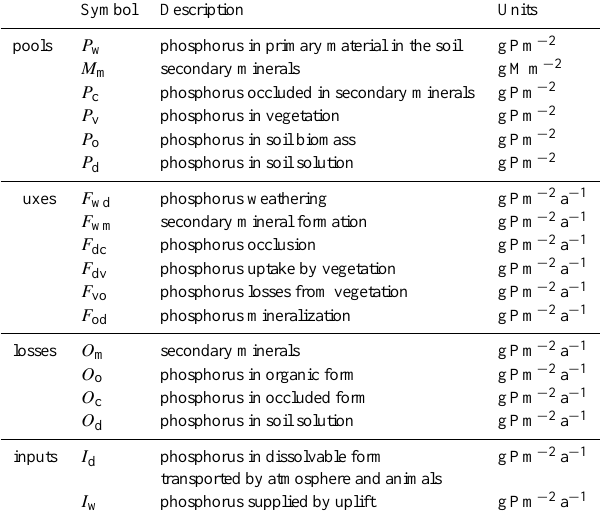
Table 1. Description of